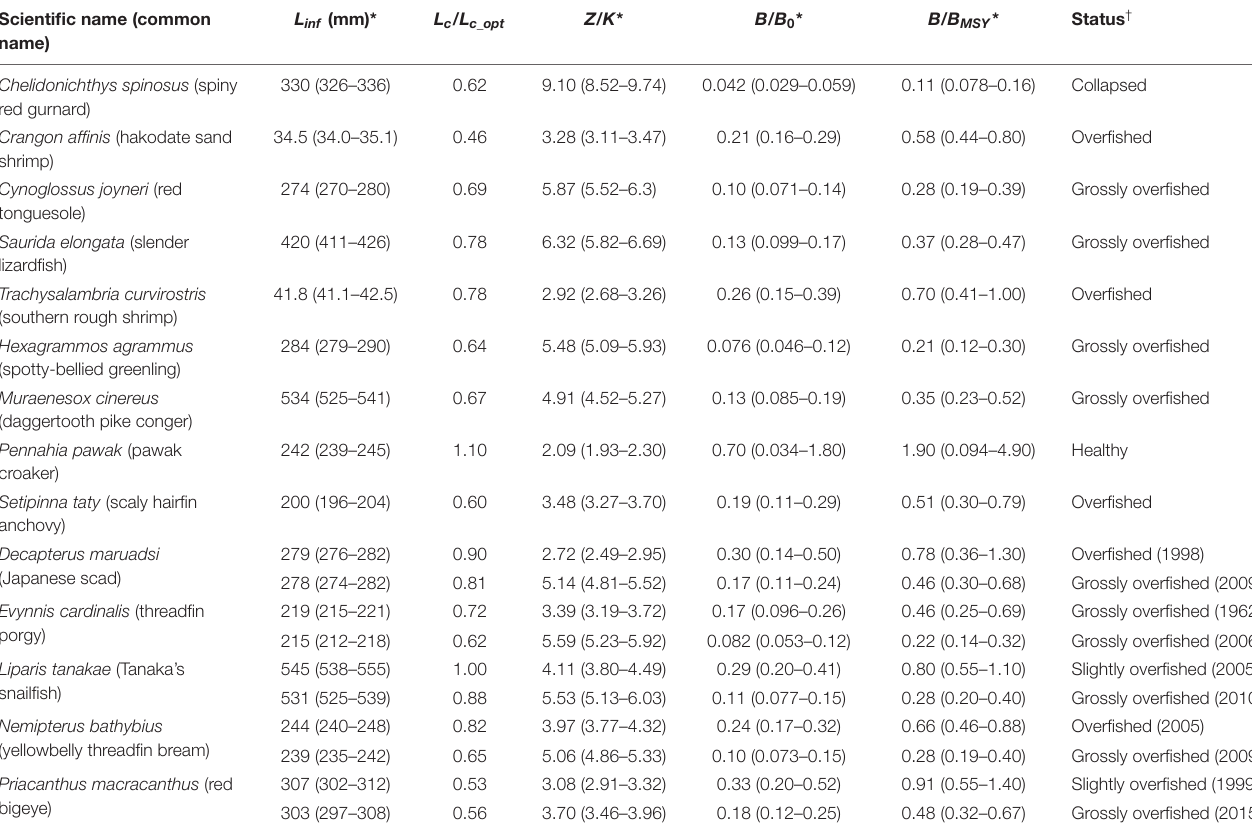
TABLE 1 | Summary of LBB results for 14